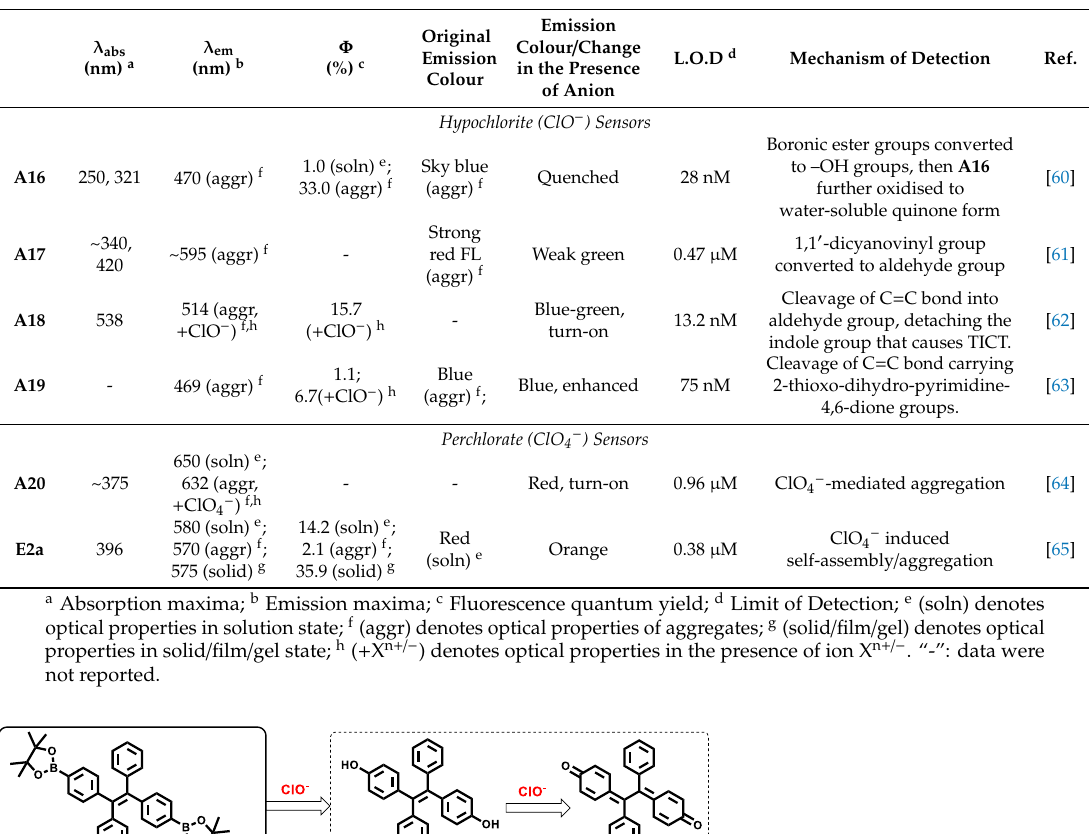
Table 3. Summary of optical properties and sensing performance of AIE-based hypochlorite chemosensors A16 – A19 , and perchlorate chemosensor A20 and E2a